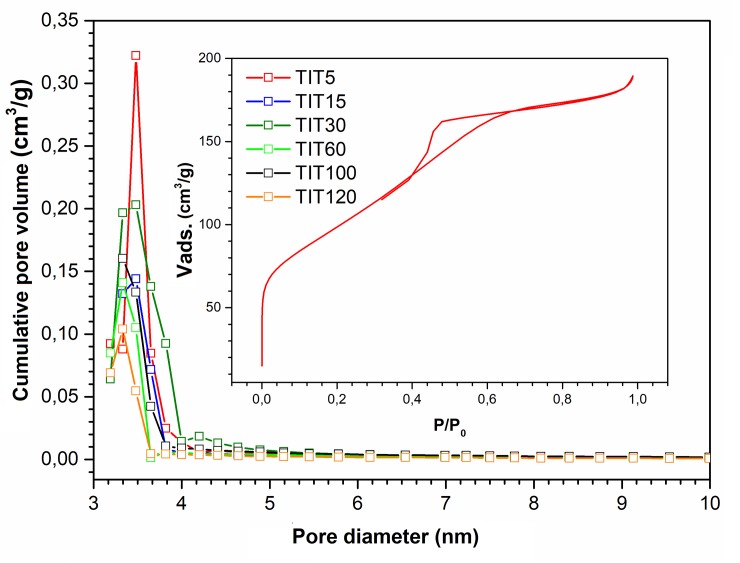
The porosity of TiO2 samples. Inset: a hysteresis loop.